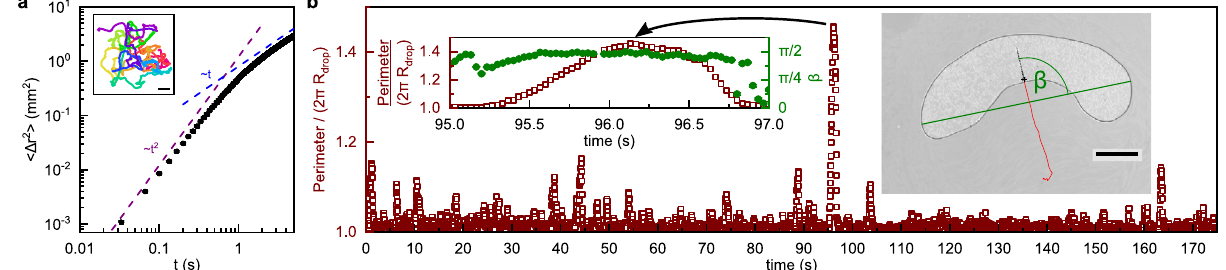
Fig. 5 Spontaneous droplet self-propulsion. a An example of the experimental mean square displacement for the drop center of mass (MSD) 〈 Δ r 2 〉 . Inset: Trajectory of the droplet center of mass for the duration of experiment. The color progression from red to violet indicates the passage of time. Scale bar is 1 mm. b Time series for the droplet perimeter normalized by the equivalent circle perimeter shows surges in droplet deformation accompanied by directed motion. The times series for the asphericity are shown in Supplementary Fig. S2. Inset: A closer inspection reveals that the direction of motion is perpendicular to the maximal caliper diameter de fi ned with an angle β (see inset snapshot, the green line is the obtained maximal caliper (Feret) diameter and the red line is the trajectory up to that moment, Scale bar is 1 mm). Experimental parameters: roller packing fraction φ = 0.28 ± 0.02, droplet area A = 10.07 ± 0.03 mm 2 , electric fi eld strength E = 4.464± 0.008MV m − 1 drop